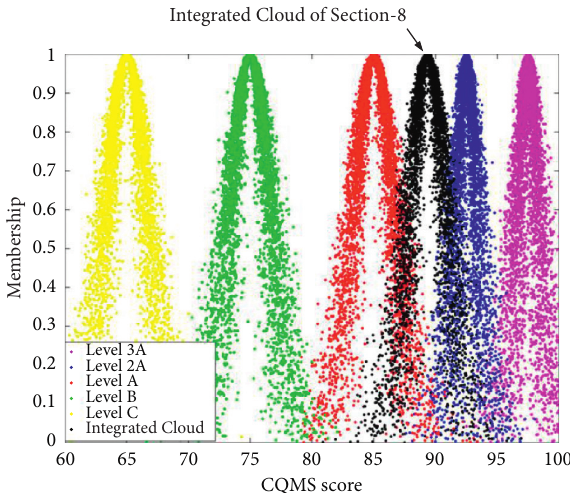
Figure 5: CQMS evaluation integrated cloud map of section 8. Table 10: CQMS inspection results and integrated cloud eigenvalues of typical